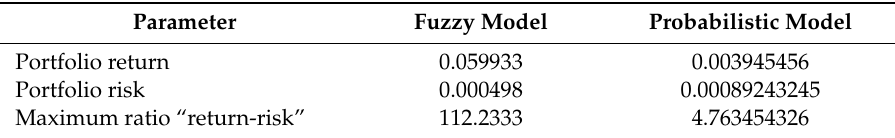
Table 3. Results of using the fuzzy set model and the probabilistic model for the formation of an optimal portfolio of corporate property